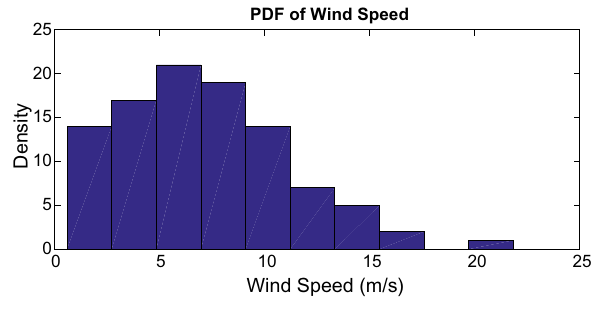
Fig. 7 Wind speed probability distribution function